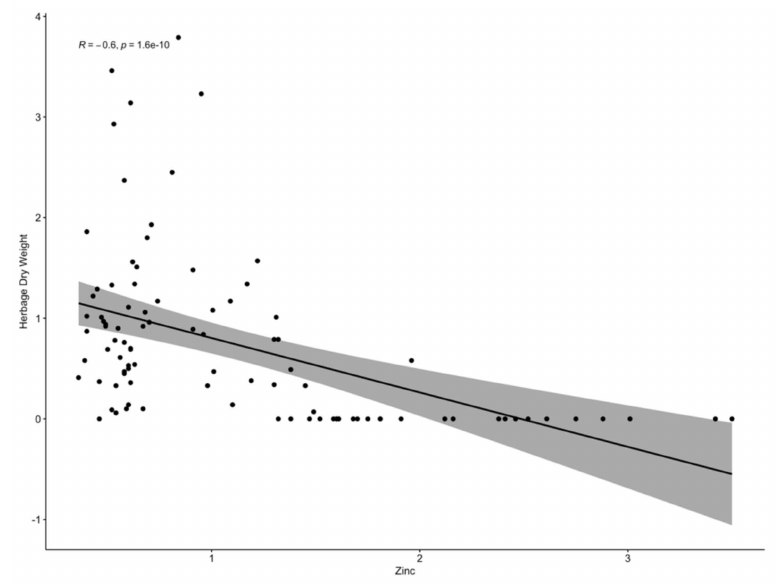
Figure 1. Herbage dry weight (H-DW) (g) × Zn (ppm), Spearman’s correlation for T. incarnatum .